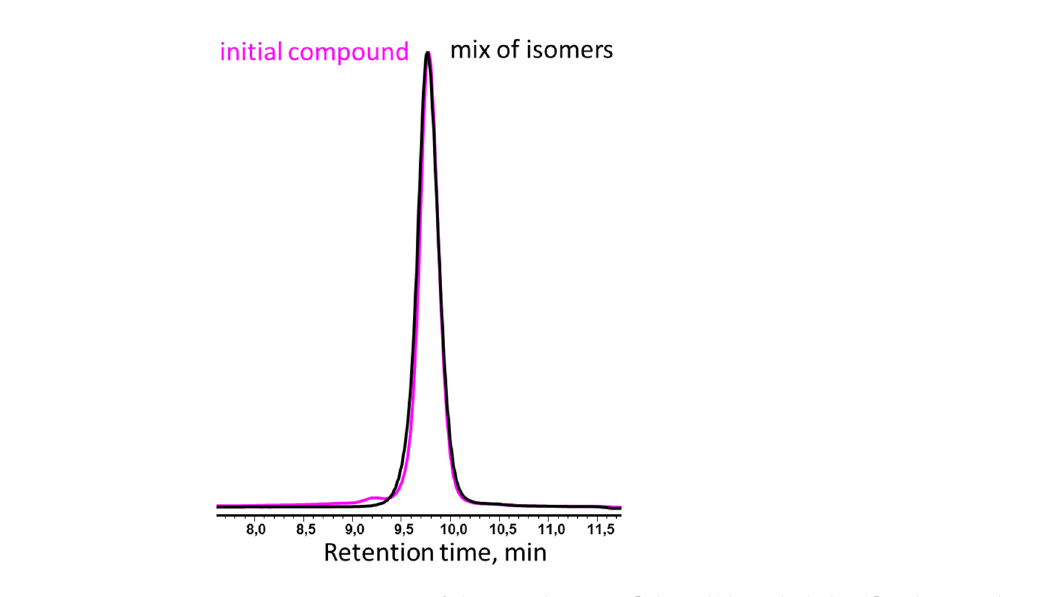
Figure 3. GPC curves of the initial cis -tetra[phenyl(dimethylsiloxi)]cyclotetrasiloxane and its mix of isomers.